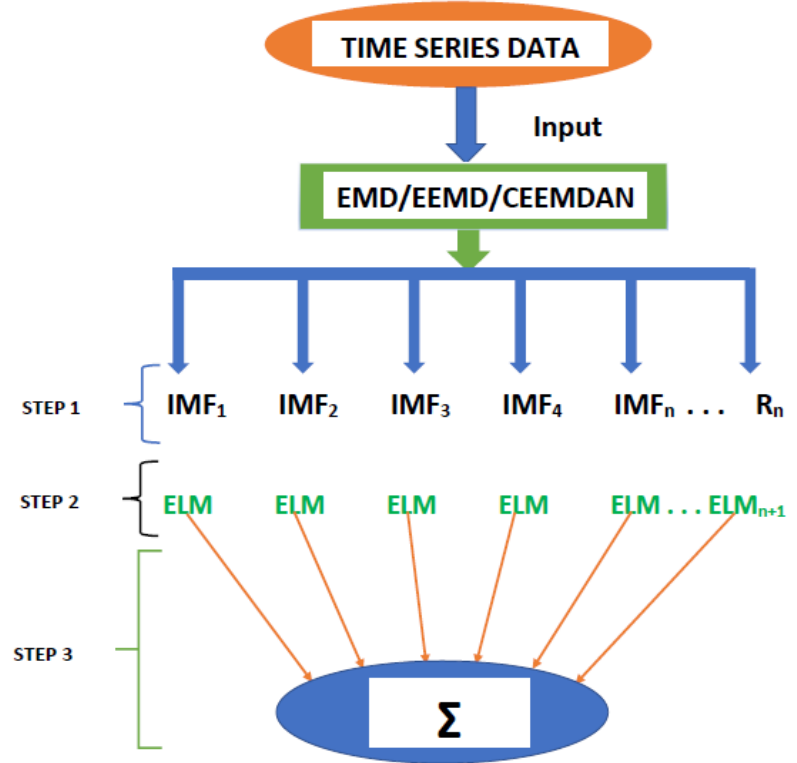
Figure 1. Flowchart of the procedures used in the hybrid modeling